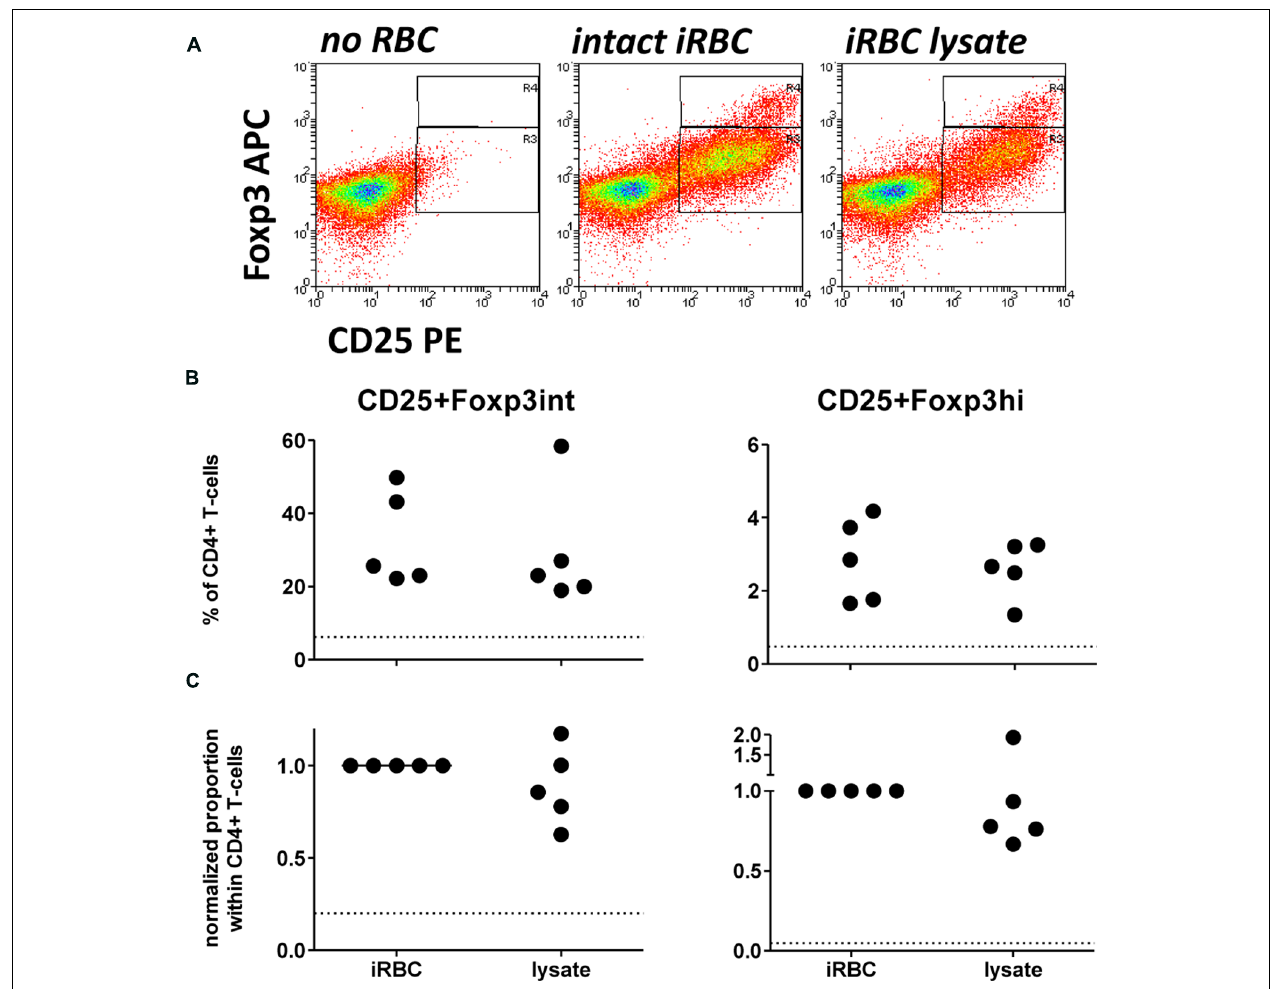
(B) Proportions of Foxp3hi and Foxp3int CD4 + CD25 + T cells were determined on day 6 as a percentage of CD3 + CD4 + T cells for five donors in two independent experiments. (C) Values of all conditions were normalized for each individual donor on proportions induced by intact iRBCs.Vertical bars represent median values. Dotted lines show the upper 95% confidence interval of the mean of uRBC-stimulated control